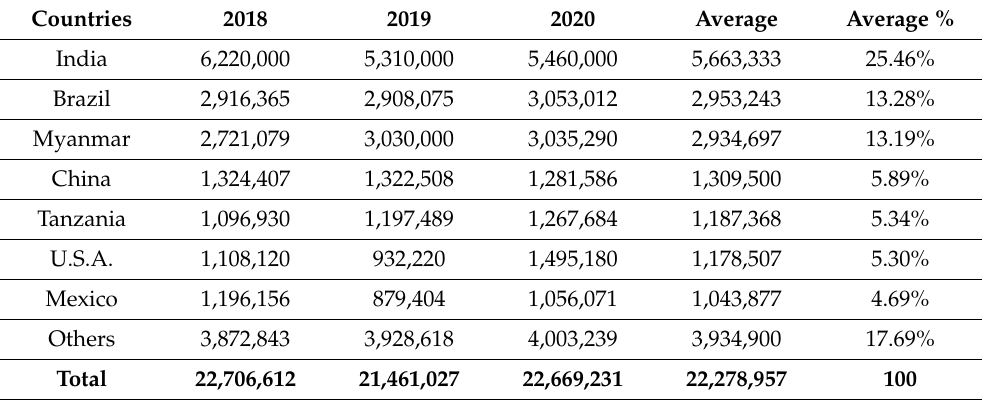
Table 1. World bean production in tons from 2018 to 2020 [2].